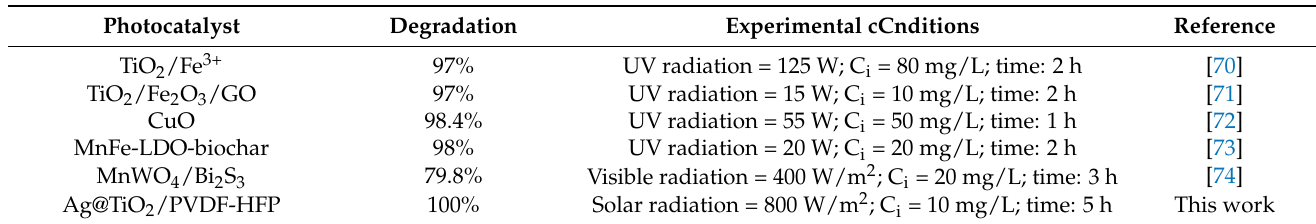
Table 3. Comparison of MNZ degradation efficiencies by different photocatalysts. Photocatalyst Degradation Experimental